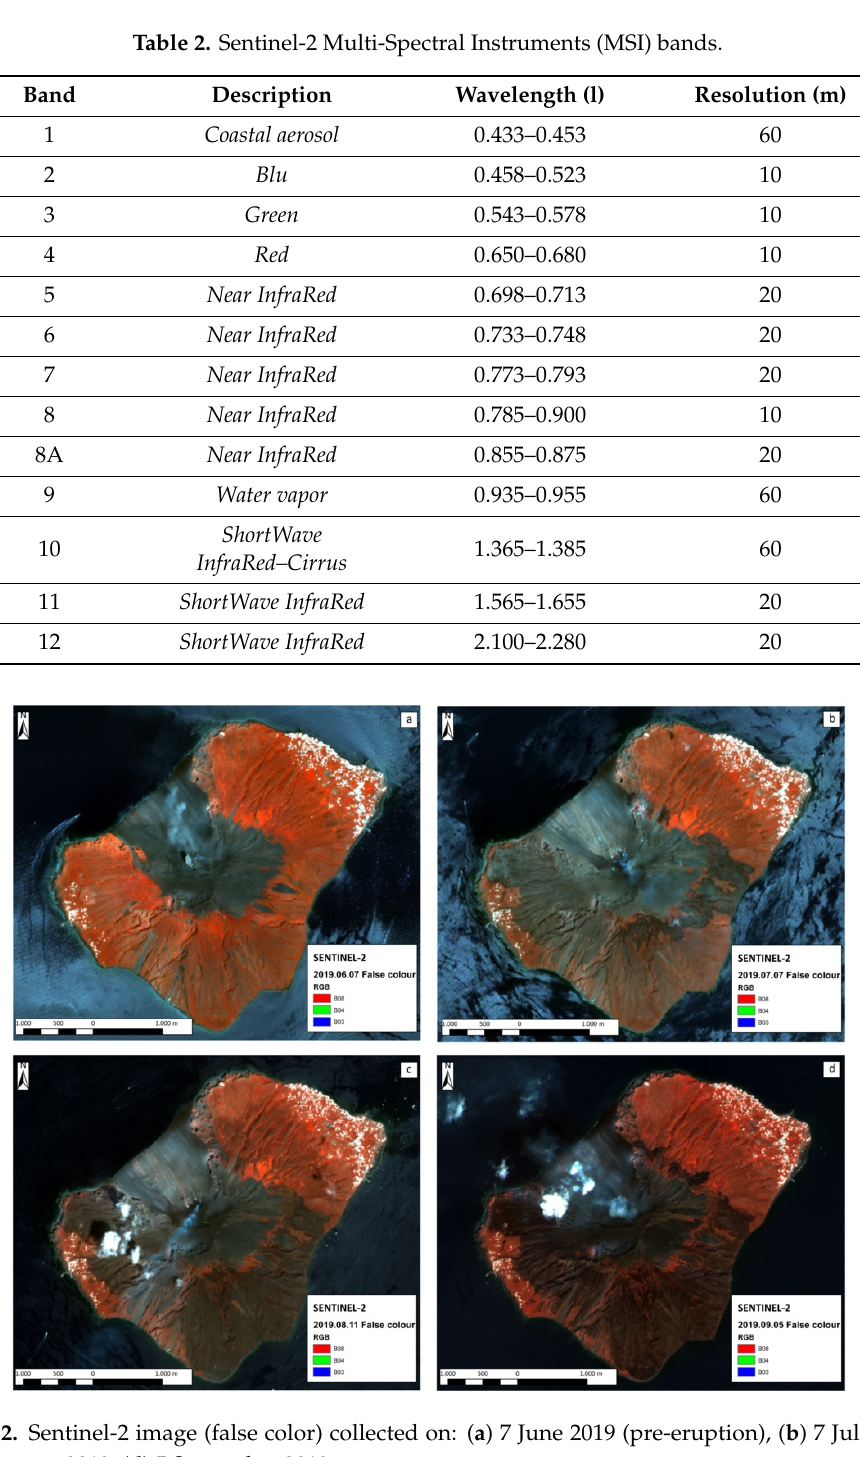
Figure 2. Sentinel-2 image (false color) collected on: ( a ) 7 June 2019 (pre-eruption), ( b ) 7 July 2019, Figure 2. Sentinel ‐ 2 image (false color) collected on: ( a ) 7 th June 2019 (pre ‐ eruption), ( b ) 7 th July 2019, ( c ) 11 August 2019, ( d ) 5 September ( c ) 11 th August 2019, ( d ) 5 th September 2019.